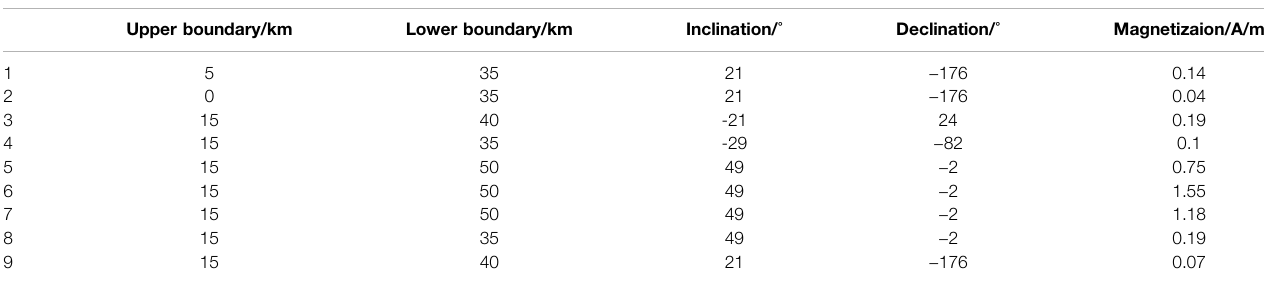
TABLE 1 | Parameters of the magnetic blocks for anomaly